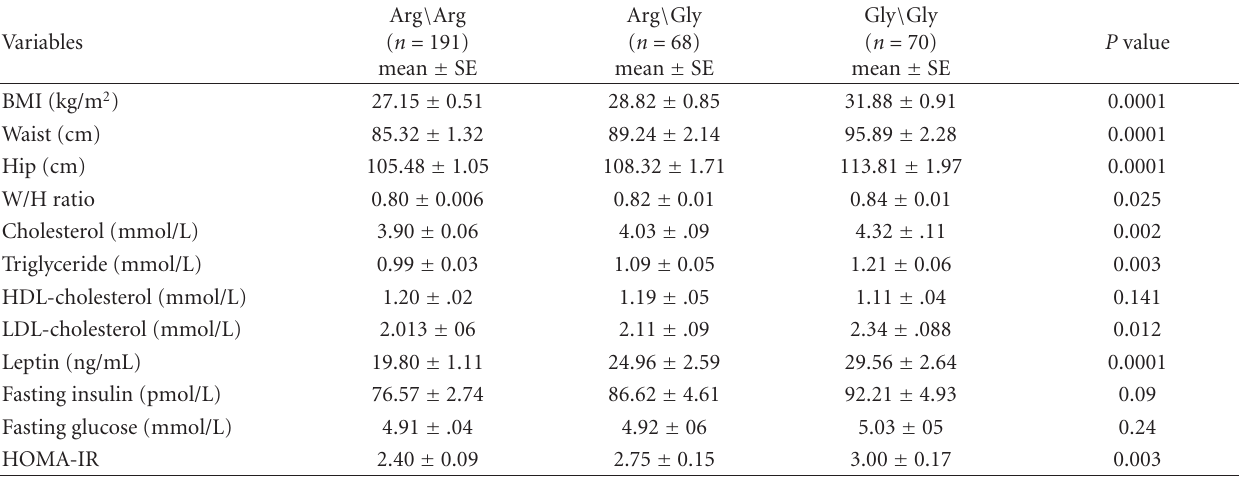
Table 4: Association of β 2AR genotype in codon 16 with phenotypic characteristics of the subjects.